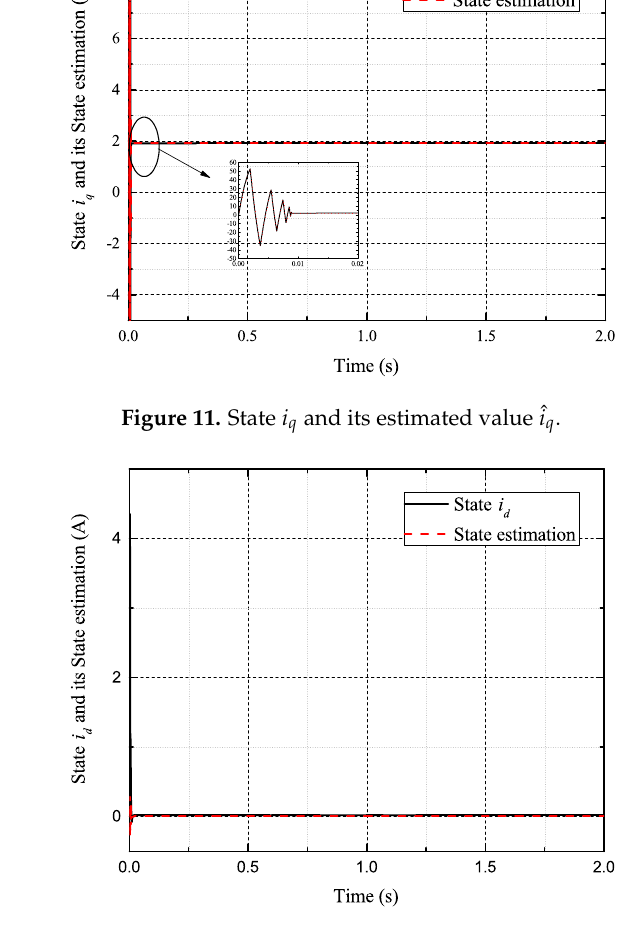
Figure 12. State i d and its estimated value ˆ i d